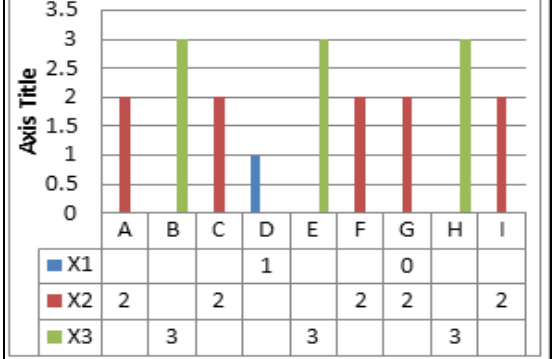
Figure 6. Residents’Interaction and duration in Iloko township market place. A =Hausa & Igbo, B =Hausa & Yoruba, C =Hausa & Hausa, D =Yoruba & Igbo, E =Yoruba & Hausa, F =Yoruba & Yoruba, G =Igbo & Hausa, H =Igbo & Yoruba, I =Igbo & Igbo. ×1= Less than 15 minutes (short interaction), ×2= between 15 to 20 minutes (medium interaction), ×3= between 20 to 30